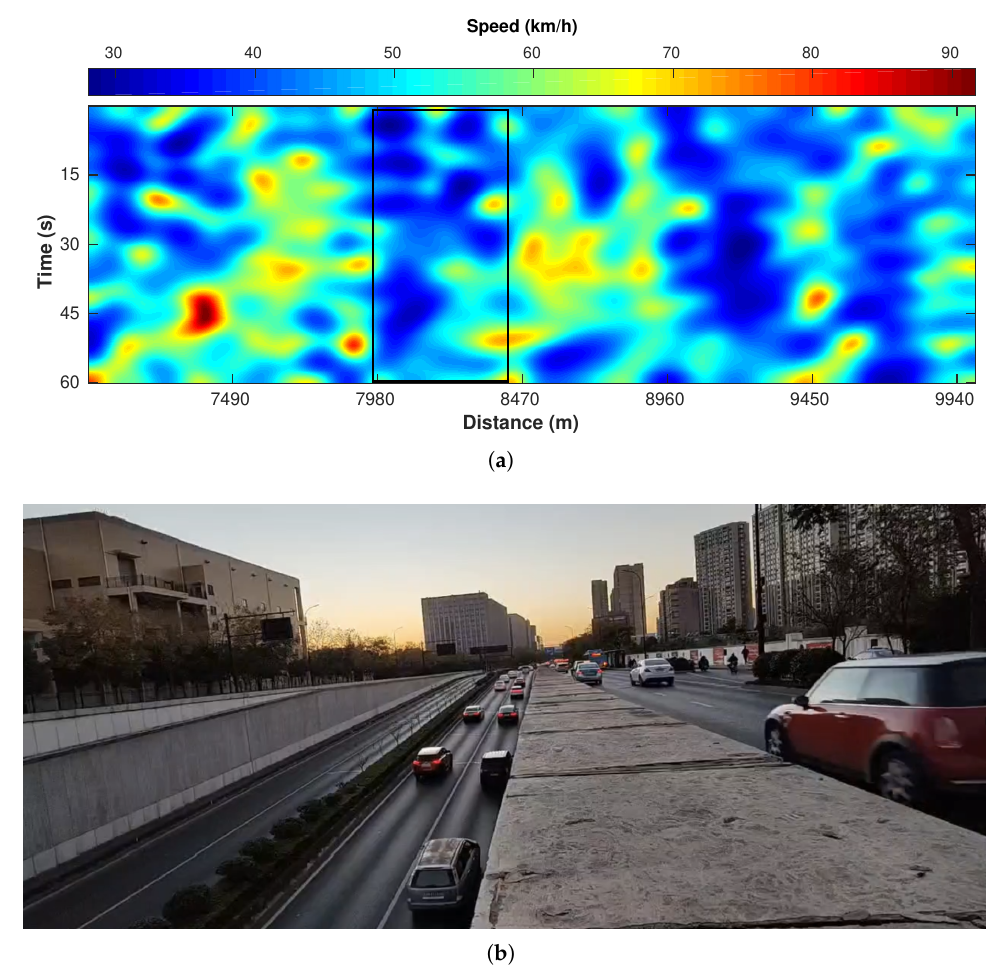
Figure 16. An example of traffic speed monitoring. ( a ) Spatiotemporal variation (one minute) in vehicle speed. The black rectangle highlight the zone with slow traffic. ( b ) A picture showing the slow down of cars, corresponding to the road segment between 7980 and 8400